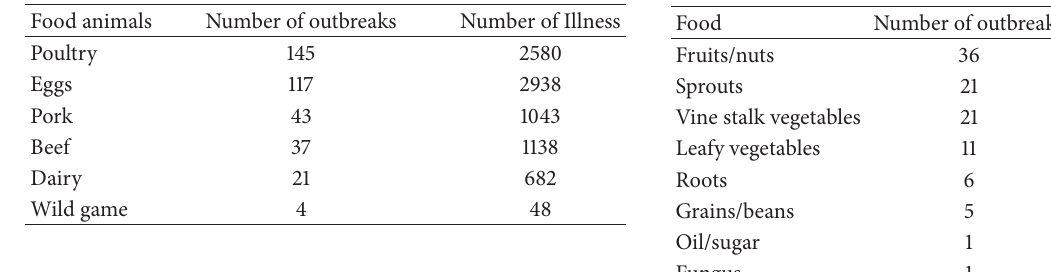
Table 2: Number of Salmonella foodborne outbreaks in the US linked to animals from 2006 to 2011 [14].